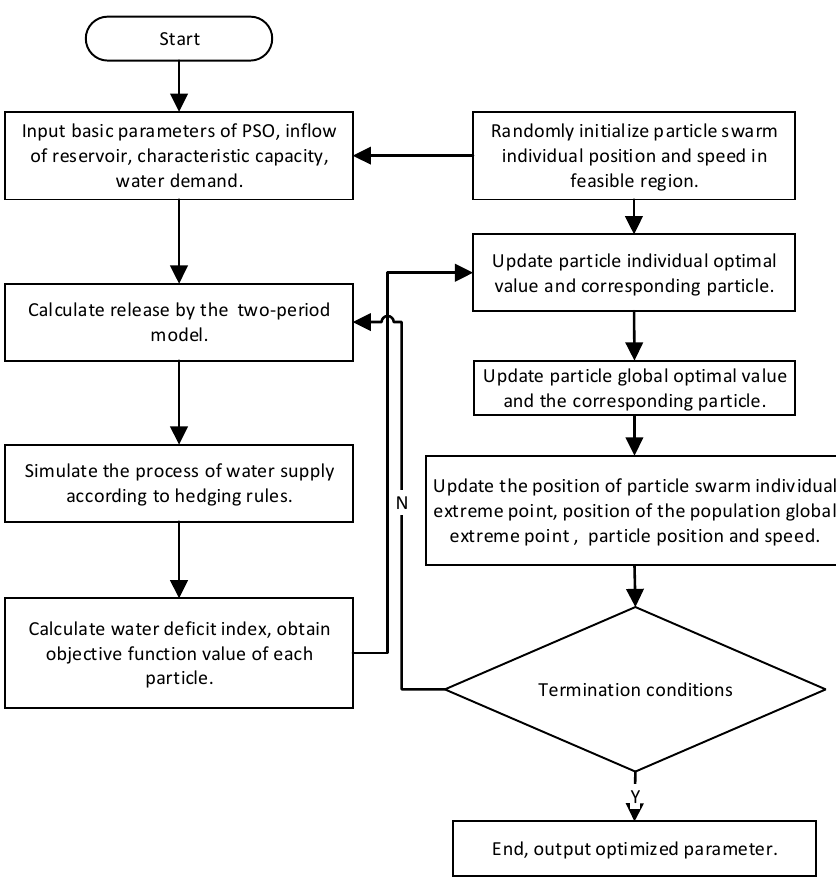
Figure 5. The flowchart of the solving simulation and optimization model for hedging rules using PSO.